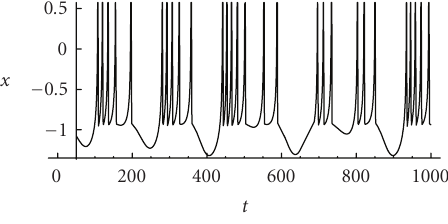
Figure 2.18. Time sequence of membrane potentials for I = 3 . 25, r = 0 . 005, and s = 4 . 0 (irregular firing pattern).